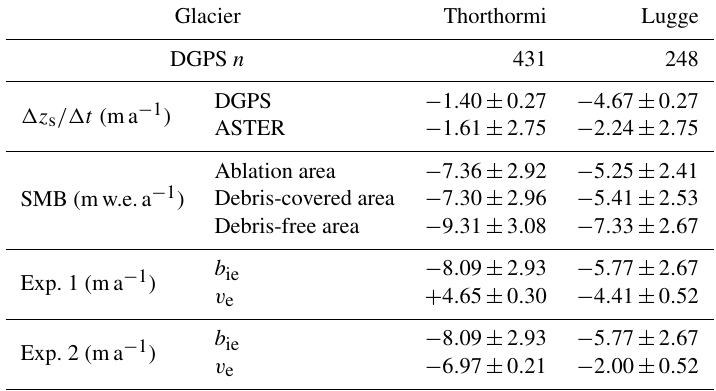
Table 1. Observed rate of elevation changes ( (cid:49)z s /(cid:49)t ), calculated surface mass balance (SMB), and simulated emergence velocity ( v e ) for the ablation area of Thorthormi and Lugge glaciers in the Lunana region, Bhutanese Himalaya. b ie denotes ice-equivalent SMB.